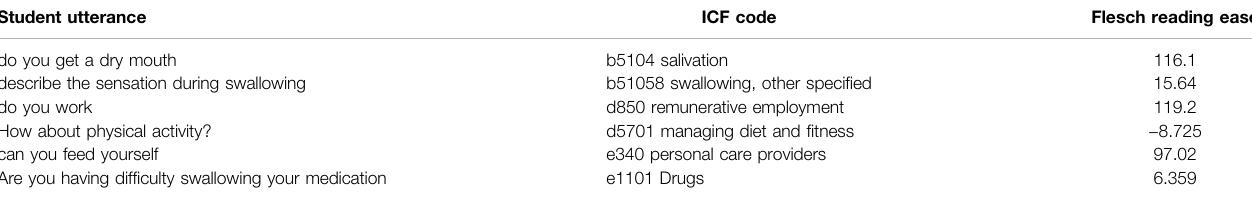
TABLE 2 | Sample student utterances with information used to calculate goal attainment and social appropriateness metrics. Student